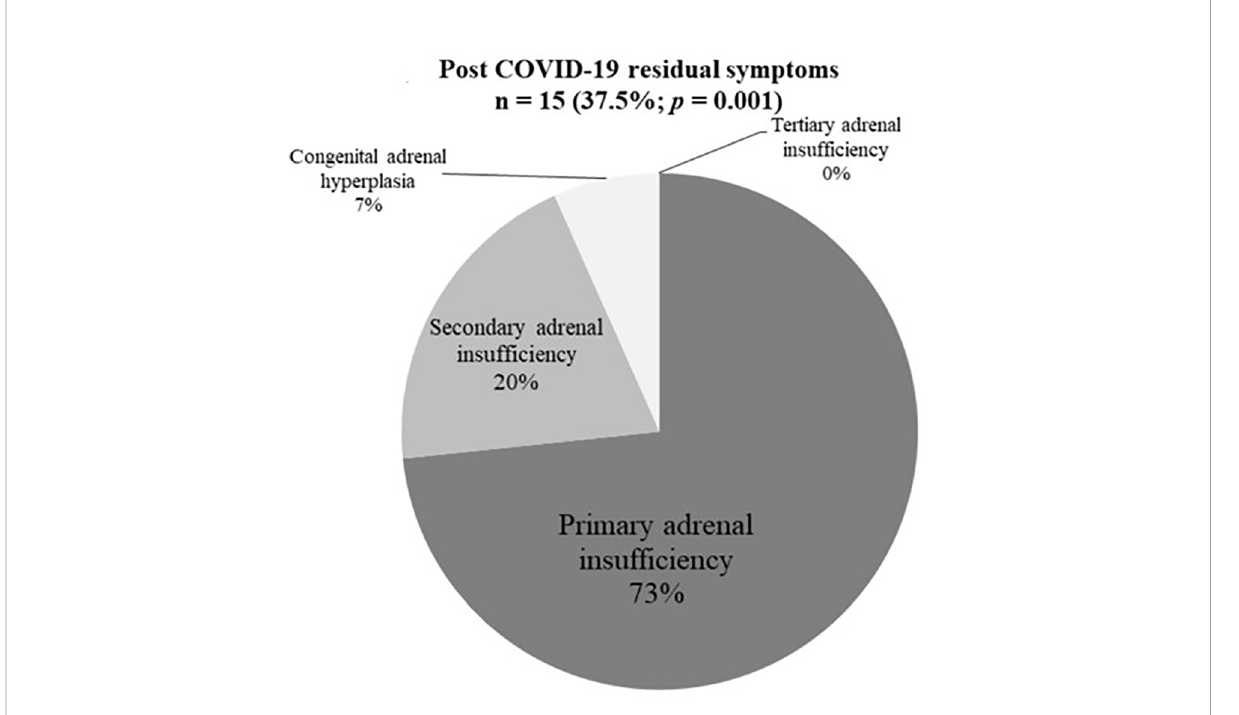
FIGURE 2 Post COVID-19 residual symptoms (n =